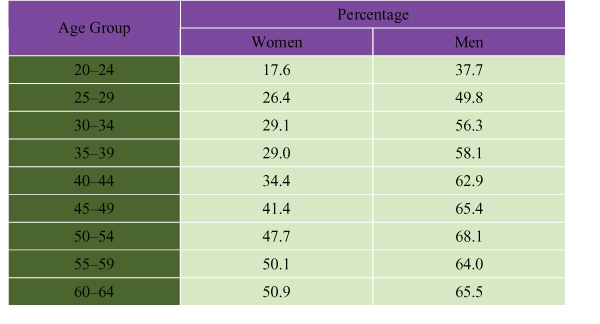
Percentage of Canadian Women and Men with a BMI Greater than or Equal to 25 in Each Age Category Source: Statistics Canada, NPHS 1996–1997